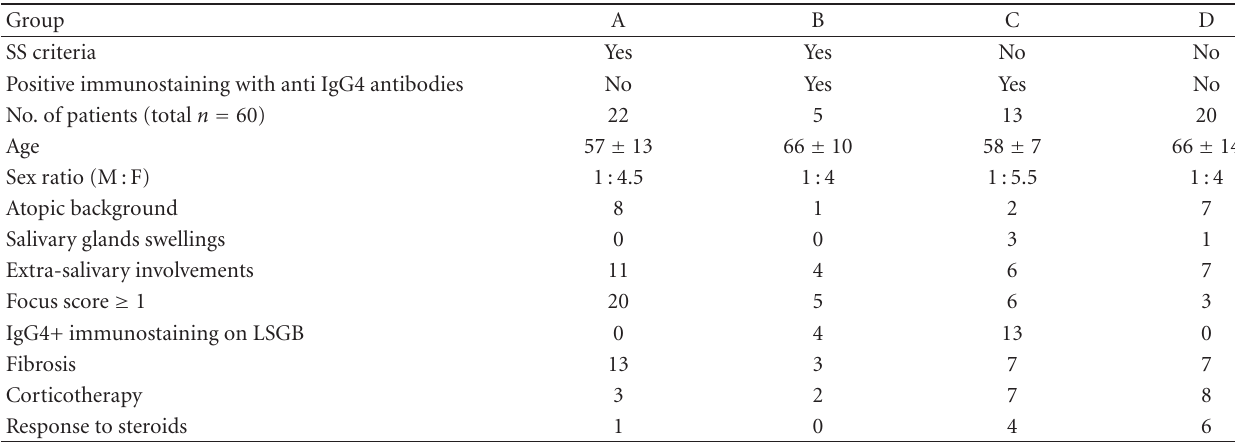
Table 1: Clinical, histopathological, and therapeutic